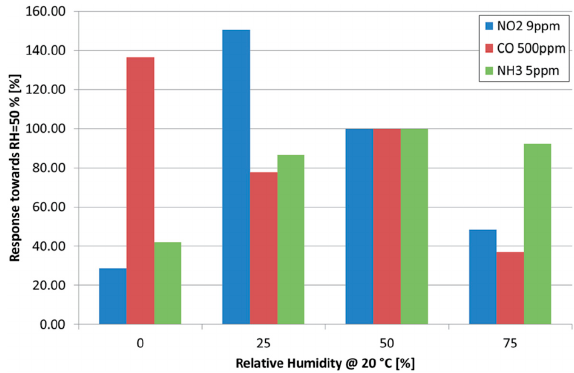
Figure 5. Influence of humidity on the 180 nm WO 3 device response to nitrogen dioxide, carbon monoxide and ammonia. The y-axis reports the ratio between the response at the target value of relative humidity with respect to the reference value of RH = 50% at the environmental temperature of 20 °C. Sensor temperature is 200 °C. Reprinted from [56]—Reproduced by permission from The Royal Society of Chemistry.